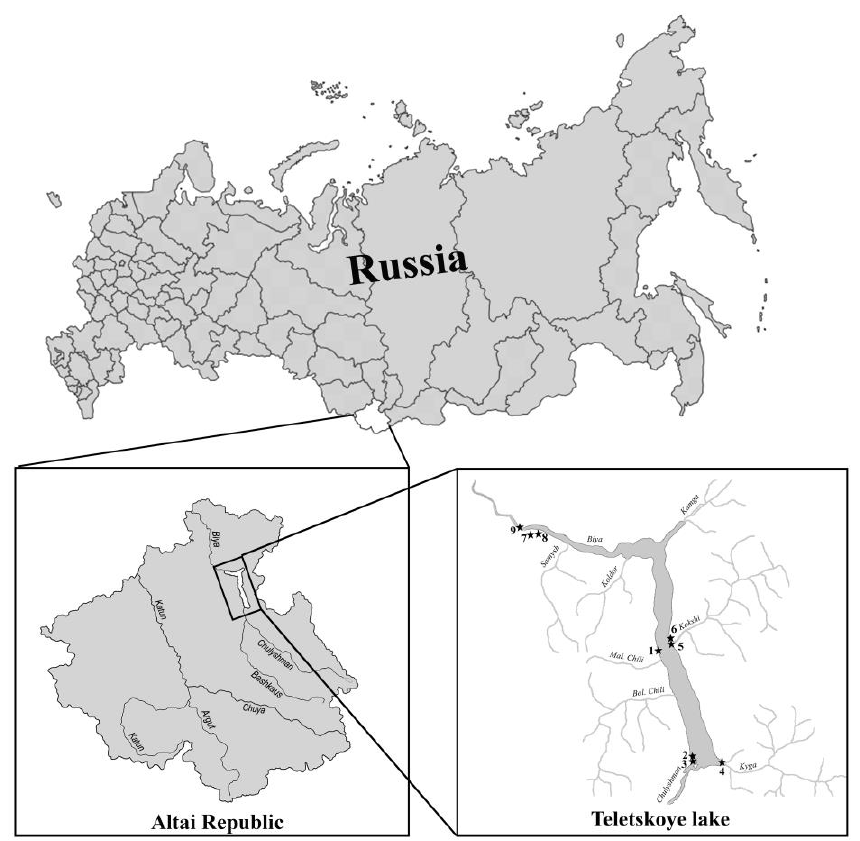
Figure 1. Geographical position of the studied area. Sample sites are marked by asterisks. (1) Teletskoye Lake, station 1; (2) Teletskoye Lake, station 2; (3) Chulyshman River; (4) Teletskoye Lake, station 3, Kyga Bay; (5) Teletskoye Lake, station 4, mouth of the Kokshi River; (6) Teletskoye Lake, station 5; (7) Unnamed lake 1 near the Biya River; (8) Unnamed lake 2 near the Biya River; and (9) Biya